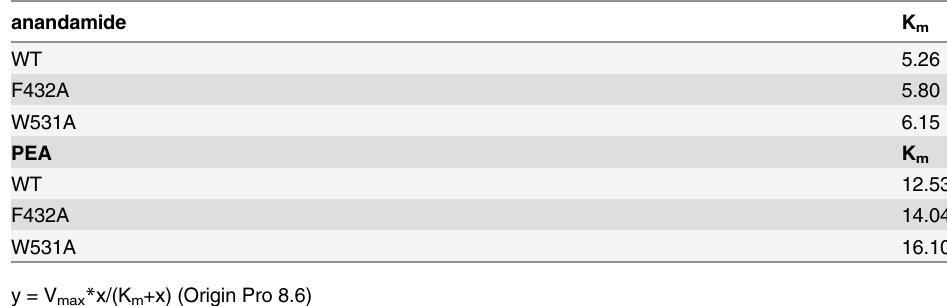
Table 1. K m obtained from the fitting of the kinetic assays (S12 Fig).